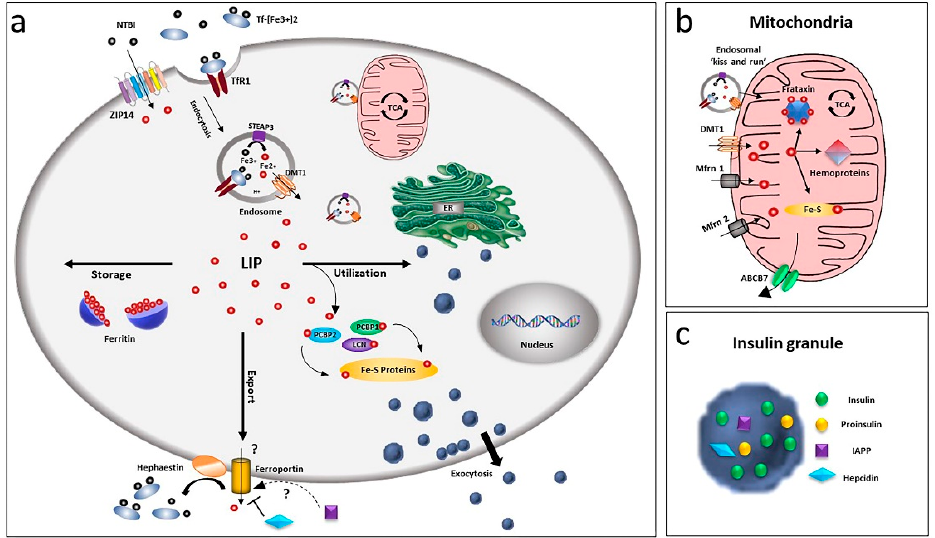
Figure 1. Overview of iron homeostasis in beta-cells. ( a ) Iron uptake in beta-cells is mediated by endocytosis of the transferrin-transferrin receptor complex and its release from endosomes by the divalent metal ion transporter DMT1. As non-transferrin-bound iron (NTBI), it can also be imported by the zinc transporter ZIP14 transporter. Being toxic as a free ion, Fe 2+ is then readily distributed for storage, bound to ferritin or for utilisation by chaperoning proteins as PCBPs and lipocalin. Iron efflux is mediated by ferroportin, a process regulated by hepcidin and hephaestin. LIP: labile iron pool. ( b ) Within the cell, the major site of utilisation is the mitochondria, where the ion is transported via DMT1 and mitoferrin (Mfrn1, Mfrn2) and inserted into heme and Fe/S cluster prosthetic groups. Mitochondria iron efflux is probably mediated by the ATP-binding cassette (ABC) transporter ABCB7. ( c ) Beta-cells, together with insulin, release IAPP and hepcidin, involved in a possible modulation of iron metabolism by an autocrine mechanism, via regulation of ferroportin.